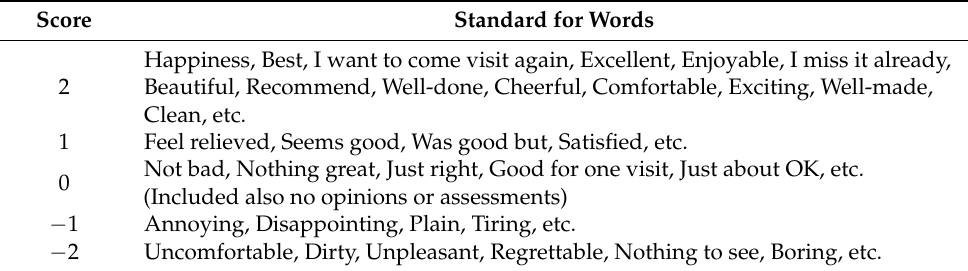
Table 1. Sentiment analysis’ scoring scheme.